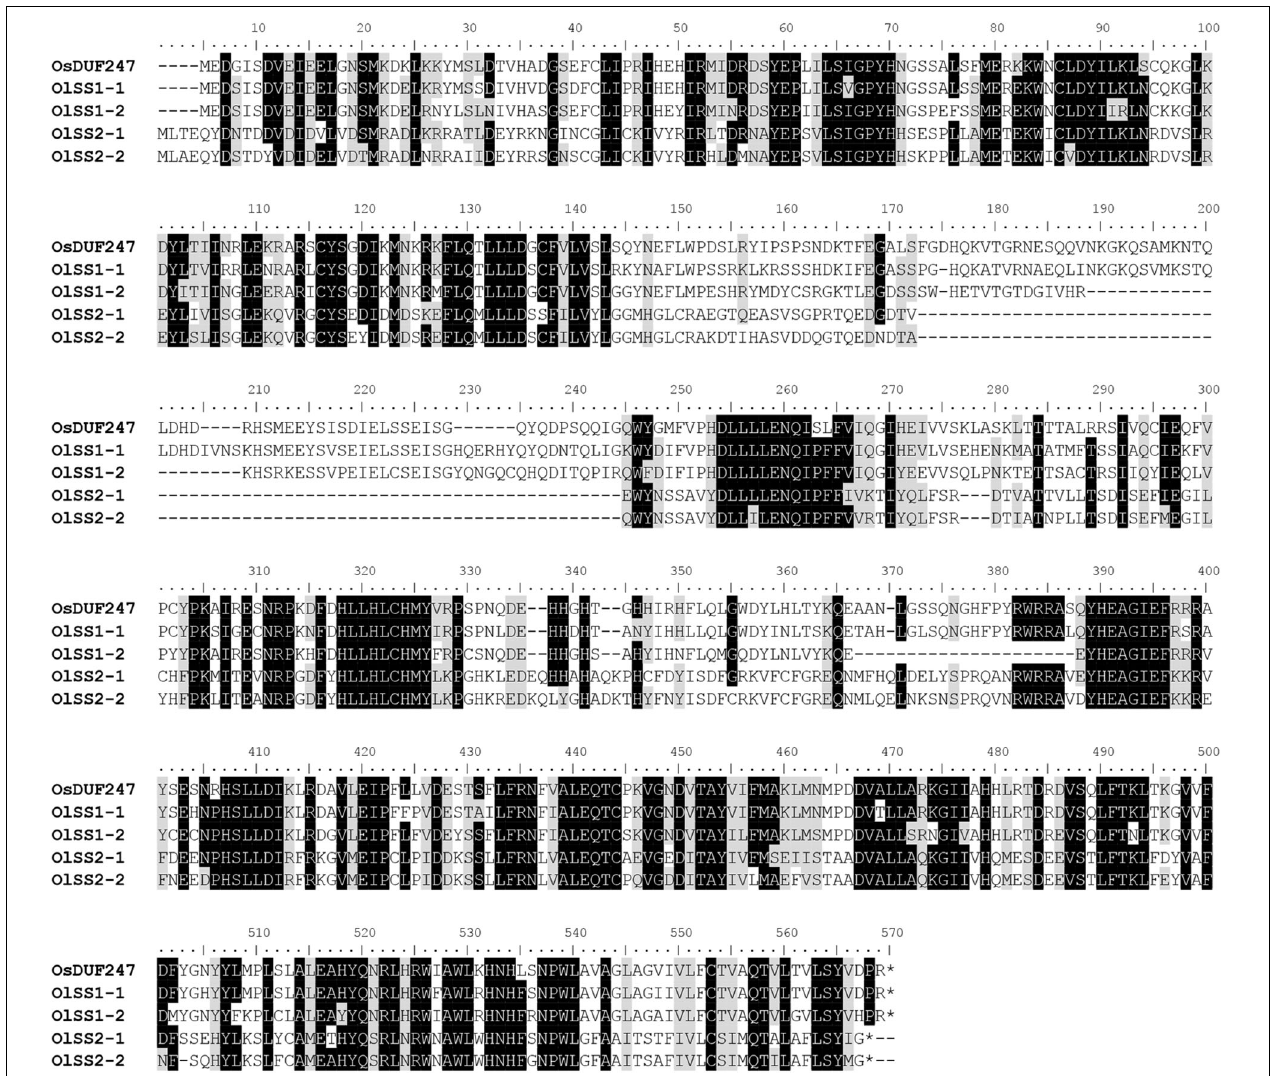
FIGURE 3 | Amino acid sequence polymorphism of OlSSs. Alignment of the amino acid sequences of OlSS1-1 and OlSS1-2 with that of OsDUF247 revealed similarities of 80.7 and 69.8%, respectively, whereas the corresponding similarities of OlSS2-1 and OlSS2-2 are 38.9 and 36.9%, respectively. Both OlSS1 and OlSS2 showed conserved regions at the N and C termini.